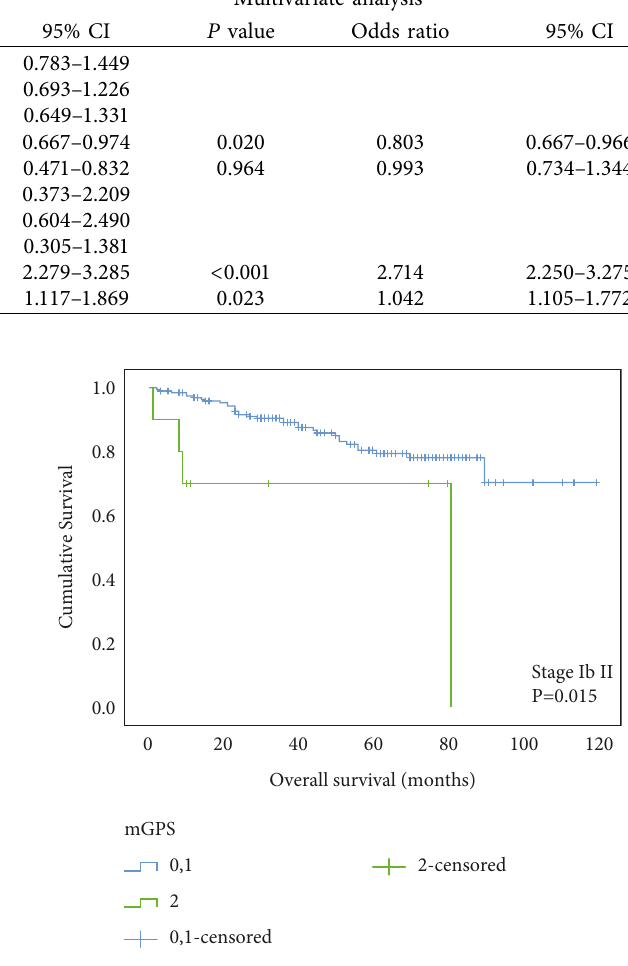
Figure 2: Relationship between the mGPS and overall survival in patients with stage Ia and II gastric